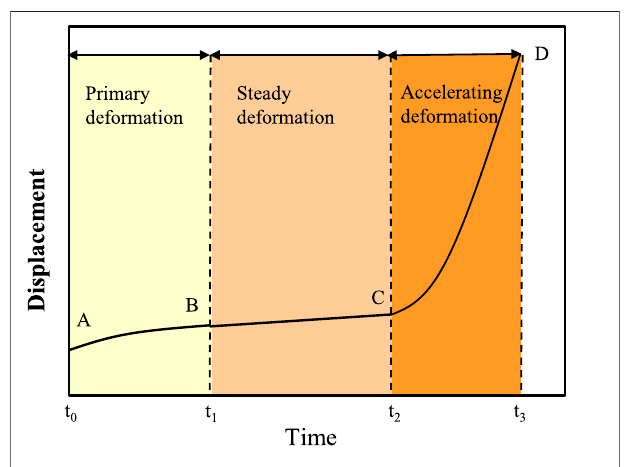
FIGURE 1 | Three stages of landslide